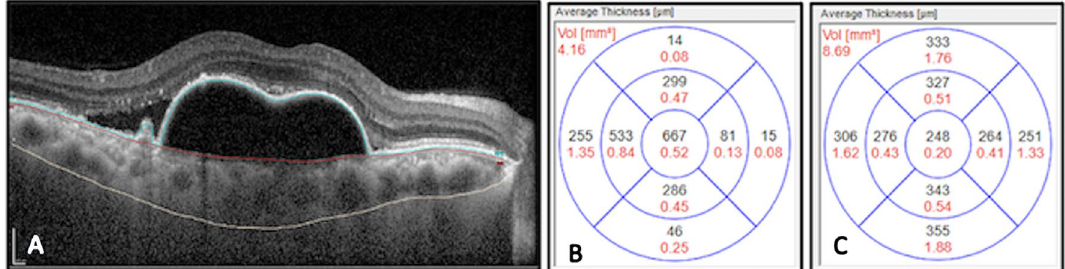
Figure 1. EDI-OCT segmentation of retinal layers and Quantification of PED and choroid thickness and volume. Manual segmentation ( A ) of retinal layers: outer margin of the Retinal Pigment Epithelium (blue line), inner margin of the Bruch’s membrane (red line) and choroid-scleral interface (white line) to generate both volume (mm 3 ) within the central 6 mm OCT ETDRS grid and thickness (µm) maps of ( B ) PED volume and ( C ) choroid thickness in treatment naïve eyes with